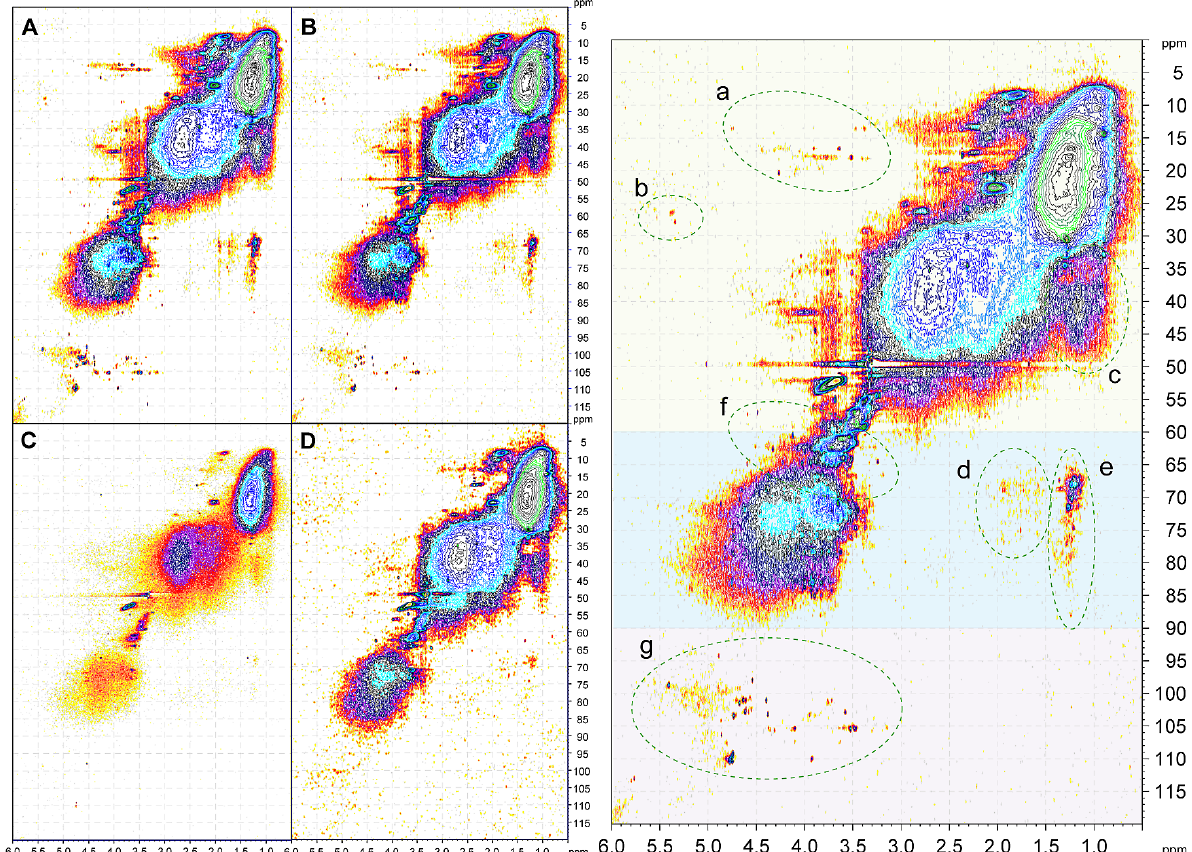
Fig. 9. HSQC-TOCSY NMR spectra of four marine SPE-DOM, aliphatic section of sp 3 -hybridized carbon: (A) 5m (near-surface photic zone); (B) 48m (fluorescence maximum); (C) 200m (upper mesopelagic zone); and (D) 5446m (30m above seafloor). For NMR acquisition parameters, see Table S3. (E) HSQC-TOCSY NMR spectrum of surface marine SPE-DOM sample from 48m. Coarse substructures, con- nected by n J HH ( n = 2–5), are given according to color; green: H C(C) C H ( δ C : 0–60ppm); blue: H C(C) C O ( δ C : 60–90ppm); and